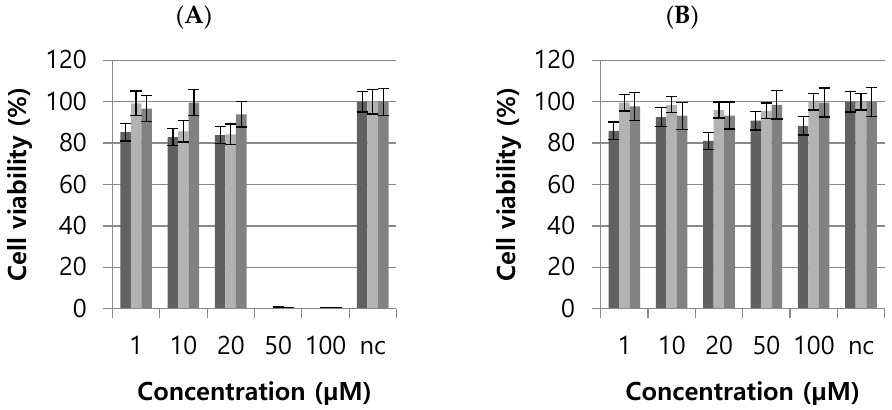
Figure 4. L929 cell viabilities after treatments with T3 ( A ) or T6 ( B ). nc, normal control. The experiments were performed with three sets at each concentration.